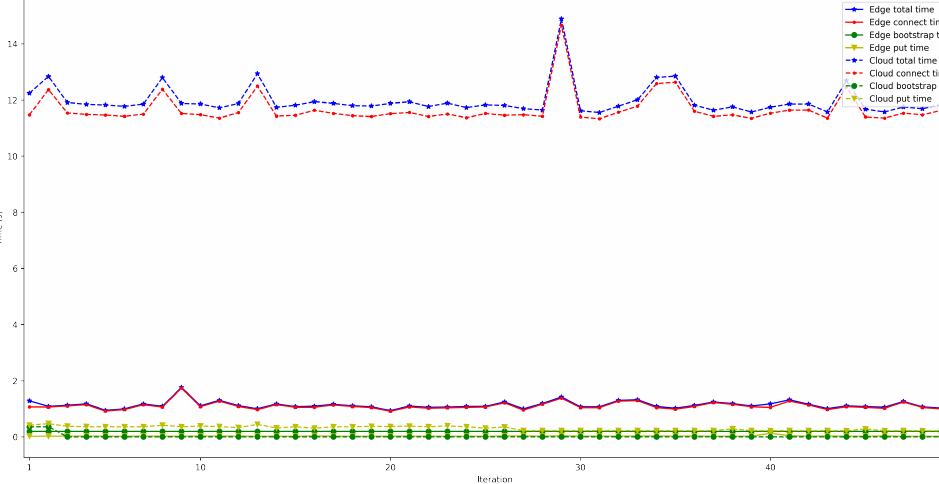
Figure 10. Latency when running the bootstrap node in the edge/Cloud for 200 connected